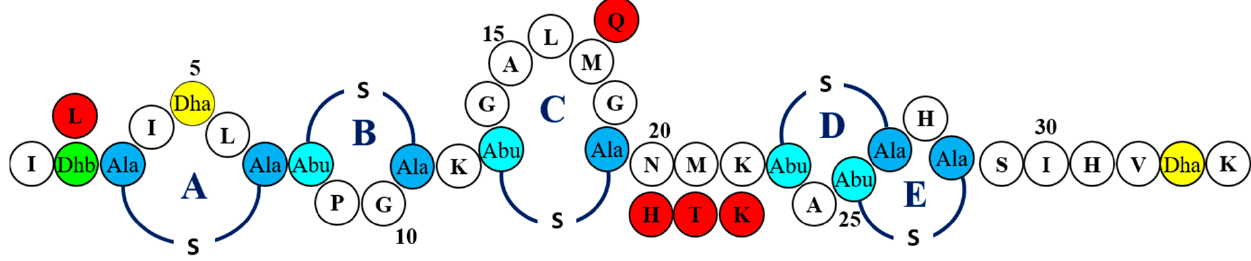
Figure 1. Primary structure of nisin A. Residues are represented in the single letter code. Post translational modifications are indicated as follows, Dha: dehydroalanine, Dhb: dehydrobutyrine, Abu: 2-aminobutyric acid, Ala-S-Ala: lanthionine, Abu-S-Ala: 3-methyllanthionine. Amino acid substitutions nisin A T2L, nisin A M17Q and nisin A HTK are highlighted in